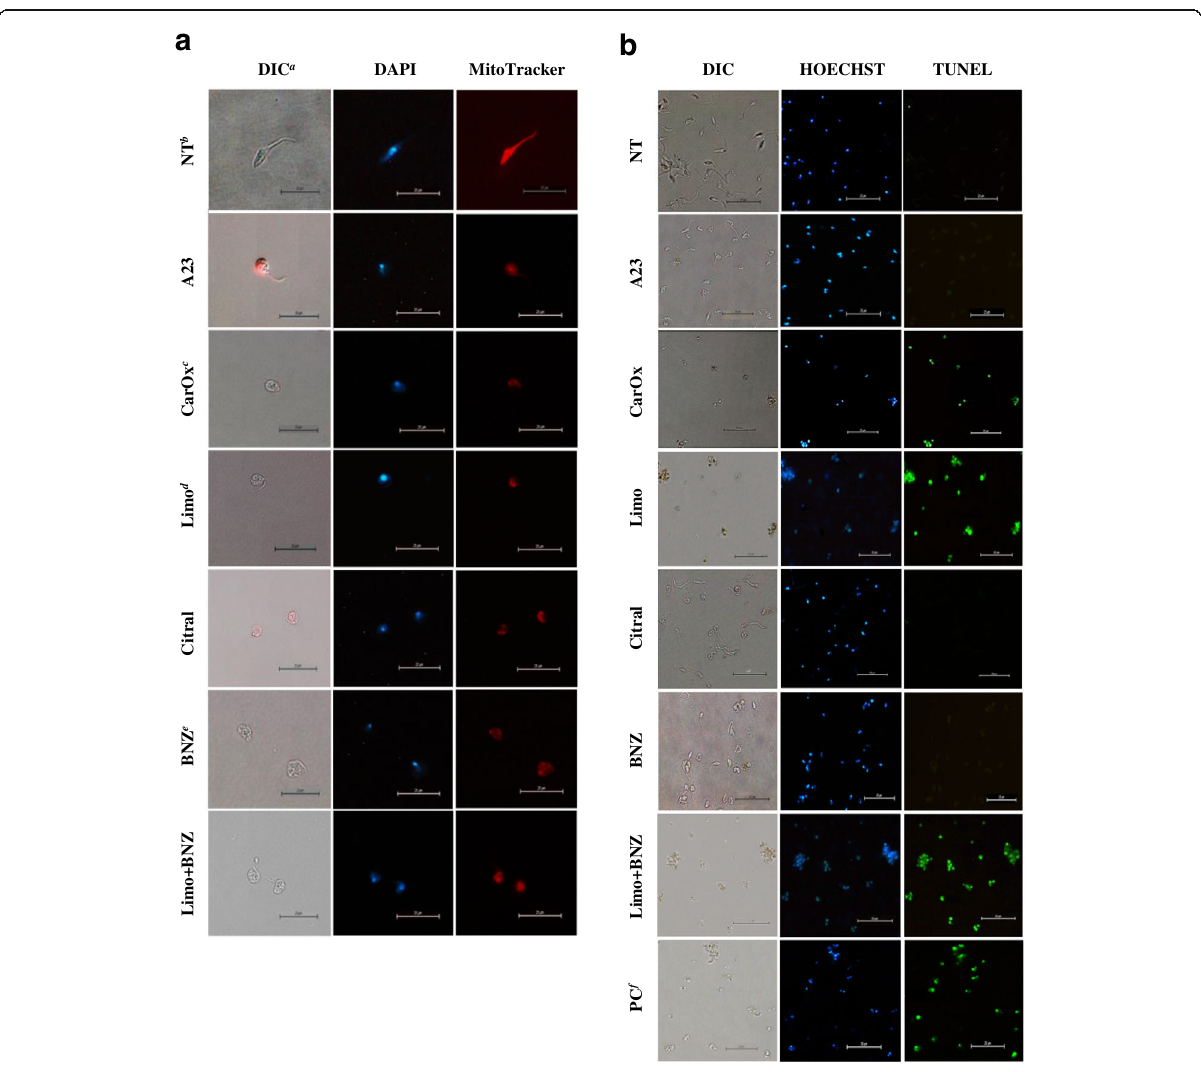
Fig. 4 Cell morphology changes of Trypanosoma cruzi by fluorescent and optical microscopy. a Cell morphology, mitochondrial membrane potential, nuclear and kinetoplast DNA of T. cruzi epimastigotes after treatment with essential oils, terpenes, or BNZ. b DNA fragmentation analysis by TUNEL assay on T.cruzi epimastigotes treated with terpenes. The preserved parasitic DNA was visualized with a blue HOECHST fluorescent probe (negative TUNEL) and the free DNA strands were observed in green (positive TUNEL). a DIC: Differential Interference Contrast Microscopy; b NT: No Treatment; c CarOx: caryophyllene oxide; d Limo: limonene; e BNZ: Benznidazole; f PC: Positive control: DAPI: cells stained with DAPI nuclear fluorescent stain observed in UV filter. MitoTracker: cells stained with MitoTracker Red CMXRos stain observed in an Excitation/Emission 579/599 (nm) filter. Photographs are representative of 10 observed